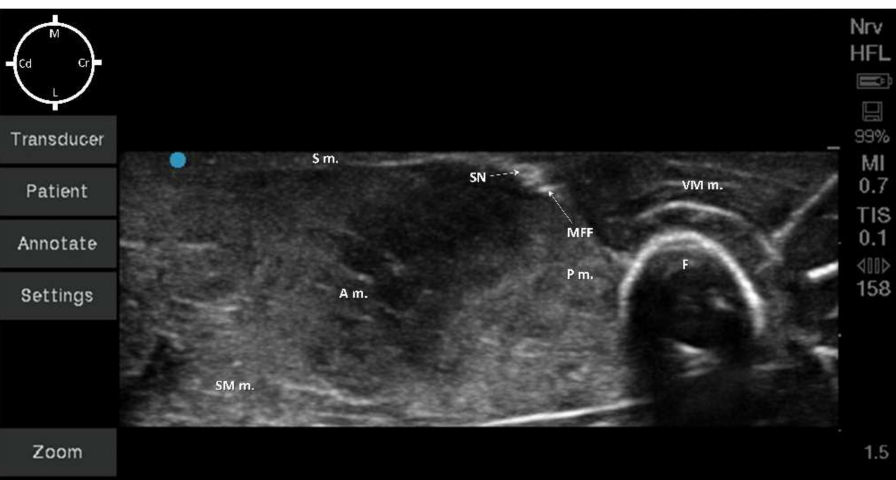
Figure 4. Sono-anatomy of the pelvic limb. The saphenous nerve (SN) can be visualized as a hyper- echoic round structure, within the same fascial plane (medial femoral fascia) of other hyperechoic round structures (collapsed femoral artery and vein due to absence of blood flow). These structures were caudally to the vastus medialis muscle (VM m.), medially and caudally to the femur (F), cra- nially and medially to the adductor (A m.) and semimembranosus (SM m.) muscles, medially to the pectineus muscle (P m.) and immediately below the sartorius muscle (S m.). MFF: Medial Femoral Fascia; M: Medial; L: Lateral; Cr: Cranial; Cd: Caudal. All the muscles (sartorius, adductor, semimembranosus, pectineus, and vastus me- dialis muscles) were displayed as structures with heterogeneous echogenicity. The femur was displayed as a hyperechoic structure with acoustic shadow. At the center of the tar- geted acoustic window, the terminal portion of the pectineus muscle was visualized